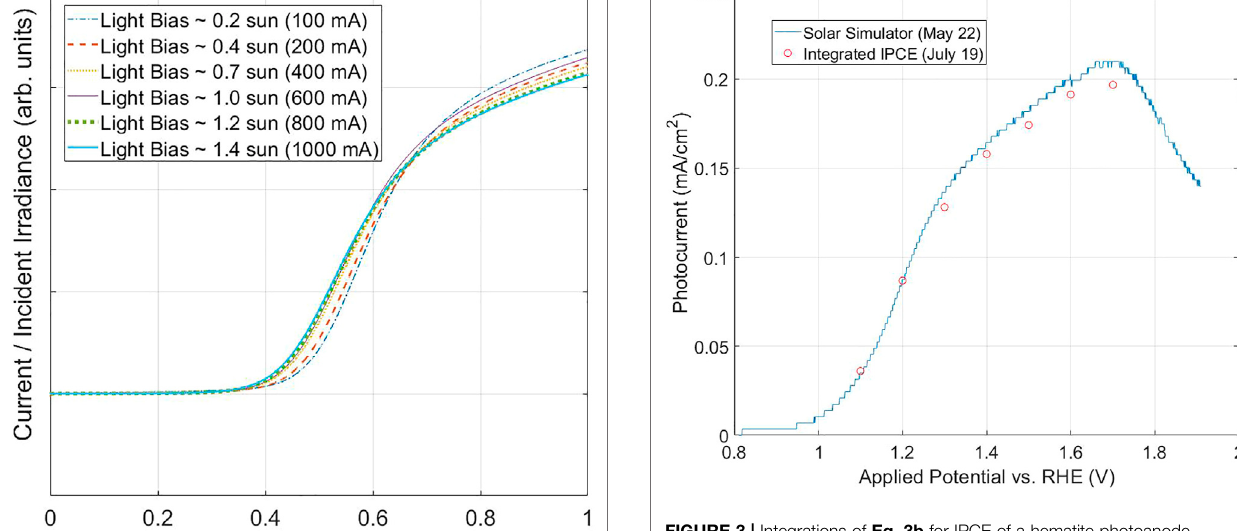
FIGURE 3 | Integrations of Eq. 3b for IPCE of a hematite photoanode (measured in white LED light bias) vs. potential, compared to the J ph -U curve measured, on a different date, under solar simulator illumination. The sample was a 1% Sn-doped hematite layer, having 85 nm thickness, deposited on ITO, on an eagle glass